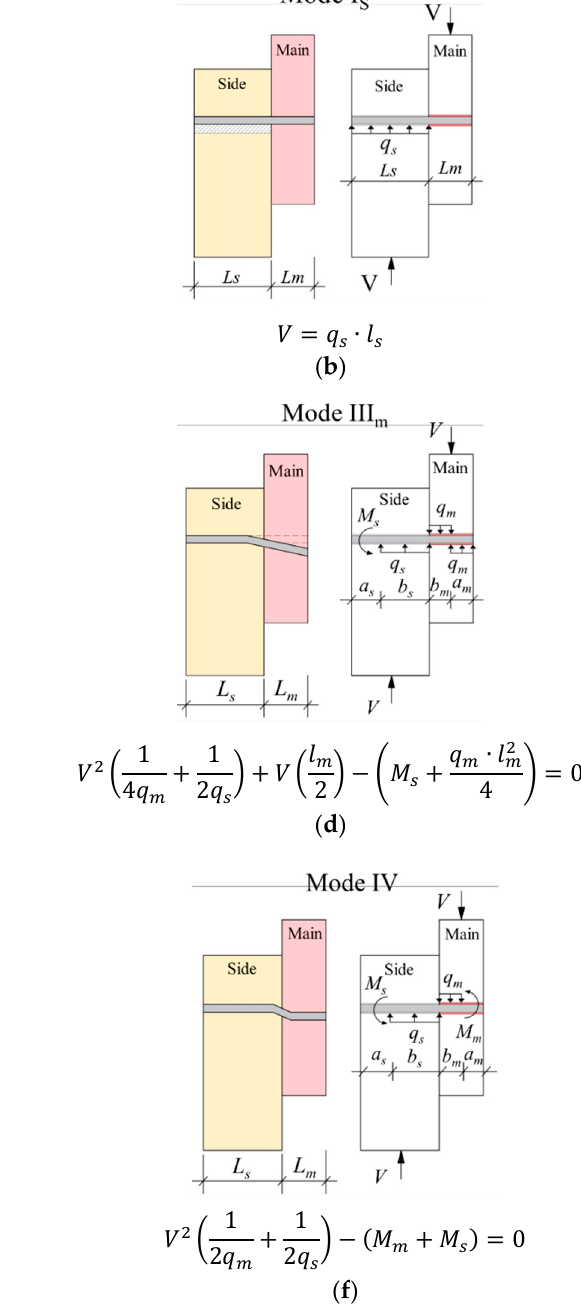
Table 7. The result of the pullout experiment.